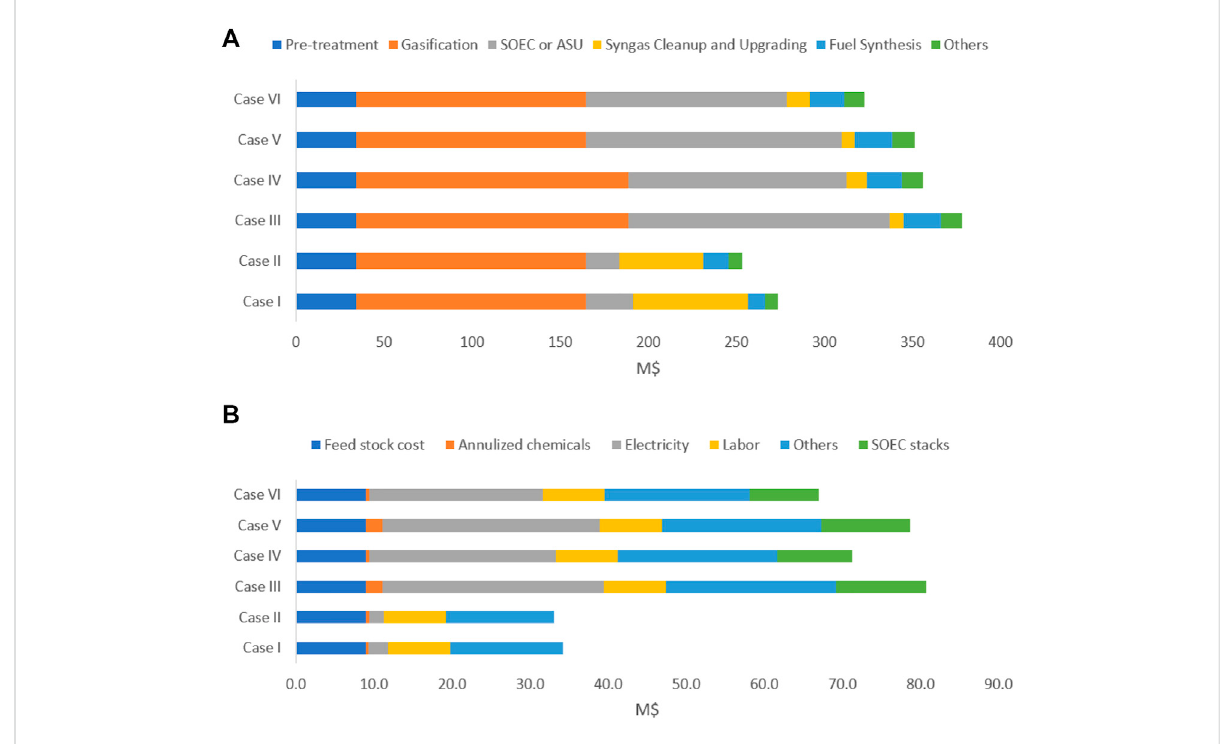
FIGURE 8 (A) CAPEX and (B) OPEX breakdown for different